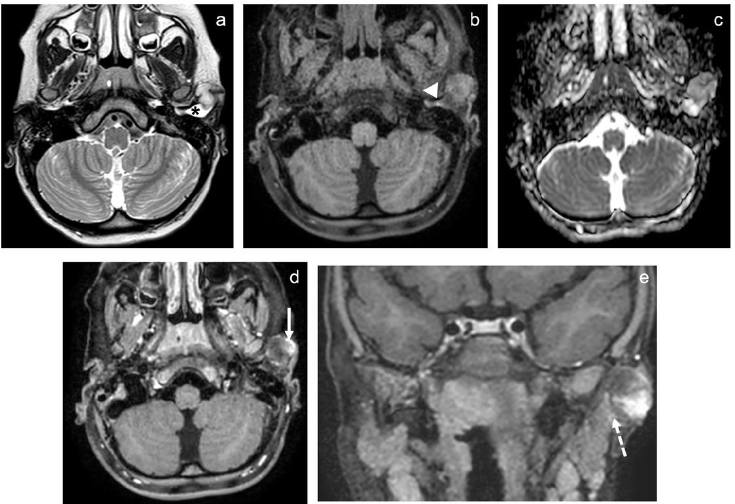
Figure 3. ( a – d ) Axial MRI FLAIR and traditional sequences. * and the white arrows show the mass and its relationship with surrounding tissue. ( e ) Coronal view shows (white interrupted arrows) the relationship of the mass with the parotid fascia and the gland.